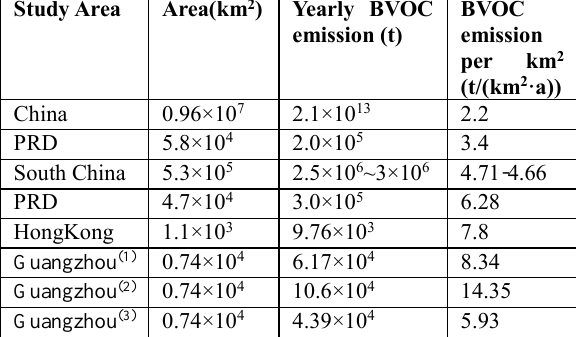
Table 2. Comparison with BVOC emissions other studies